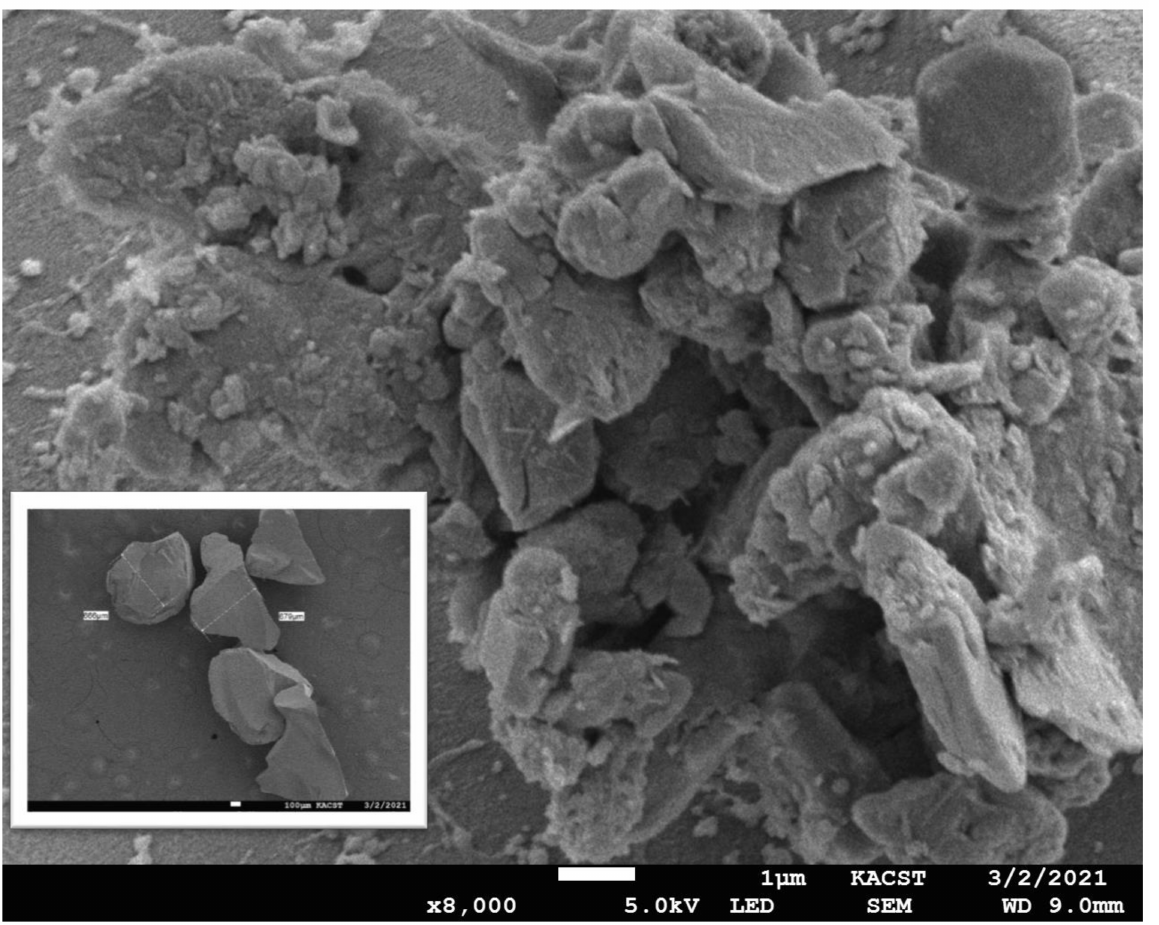
Figure 3. SEM image of silica gel particles; image scale bar indicates 1 µ m. The inset image shows that their average size is above 500 µ m.